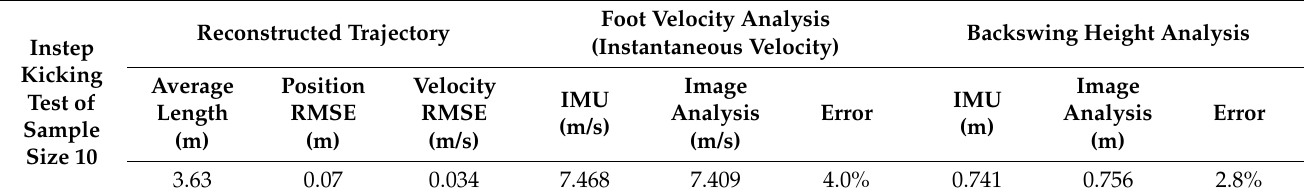
Table 1. Comparison of reconstructed trajectory, instantaneous velocity and backswing height generated by IMU data with high-speed cameras’ results.